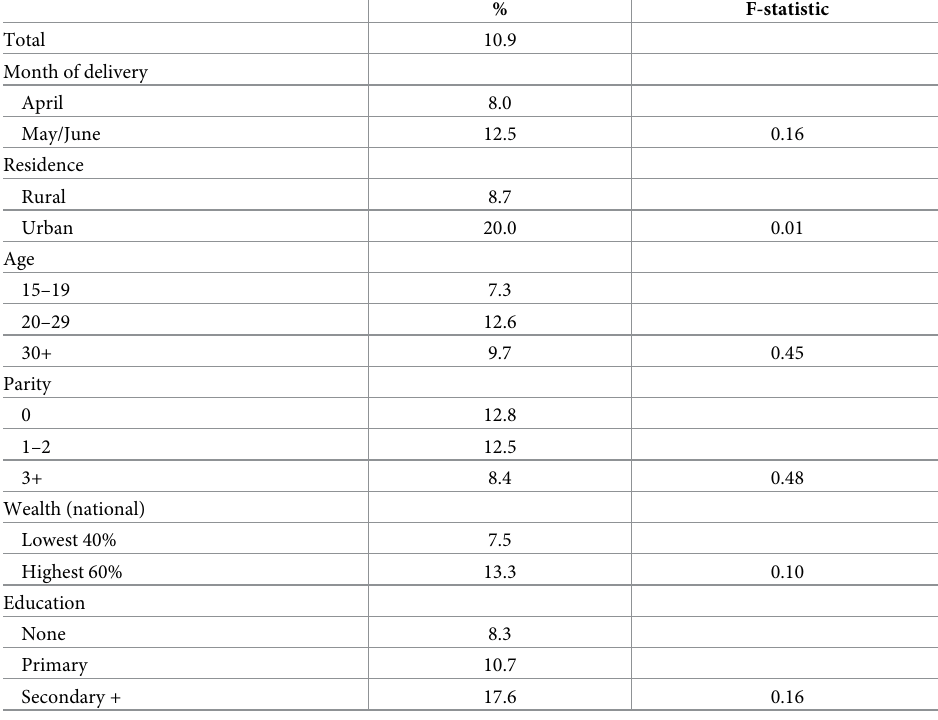
Table 5. Bivariate association of select characteristics and reporting that place of delivery was affected by COVID-19 among women who delivered April 8th, 2020 and after.